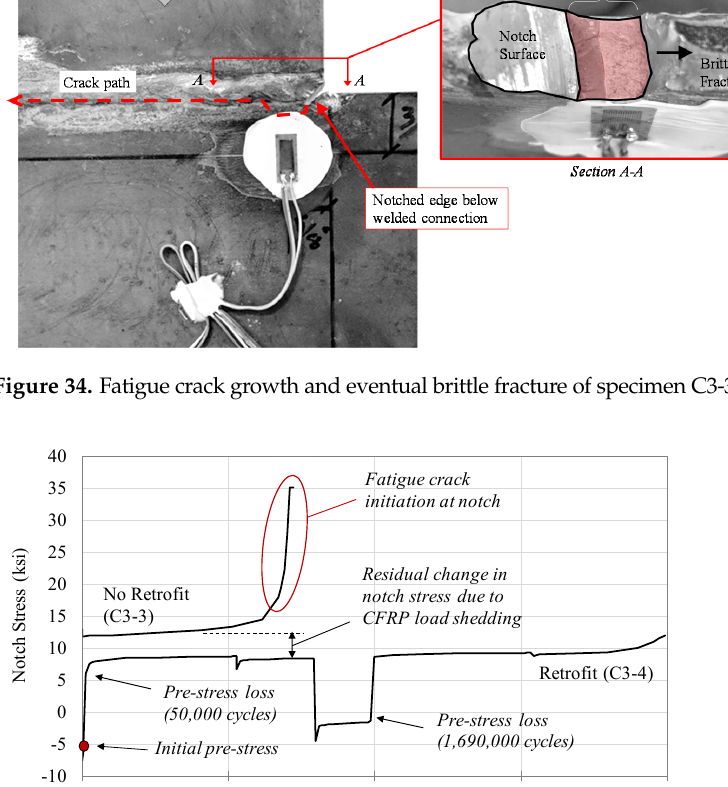
Metals 2022 , 12 , x FOR PEER REVIEW 28 of 30